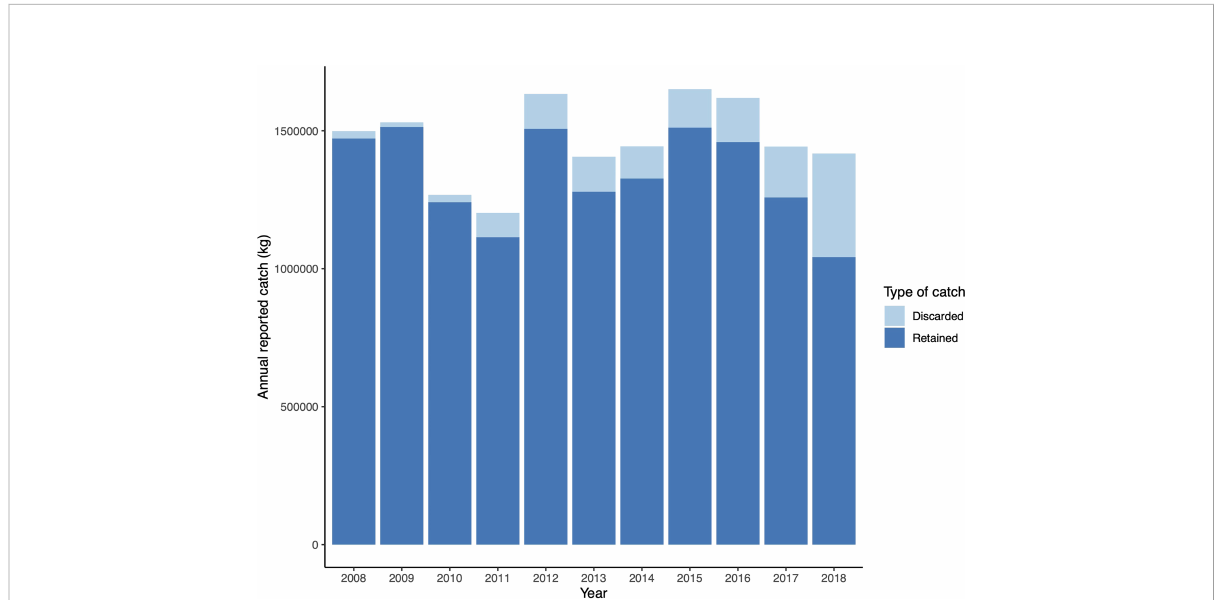
FIGURE 3 Retained and discarded catch data near oil and gas structures in the Bass Strait from